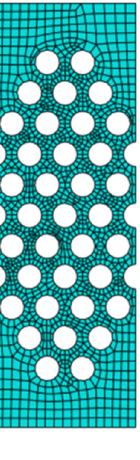
Figure 11: FE mesh.